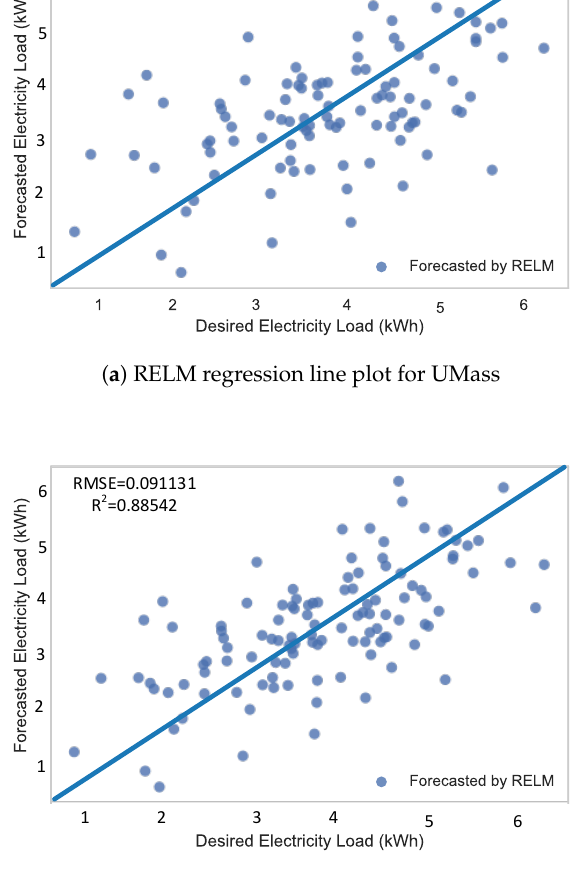
( b ) RELM regression line plot for UCI Figure 13. Regression line plots using